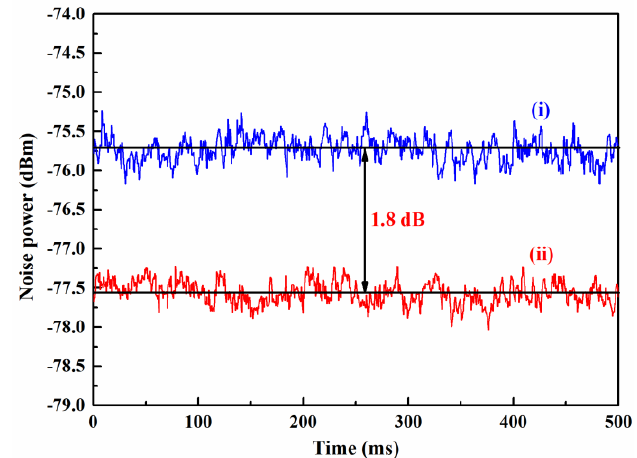
Figure 3. Measured noise power of the intensity difference between two down-conversion beams. Curve (i): the corresponding shot-noise level (SNL), curve (ii): the noise power of the intensity difference between the twin beams. The analysis frequency is 5 MHz.